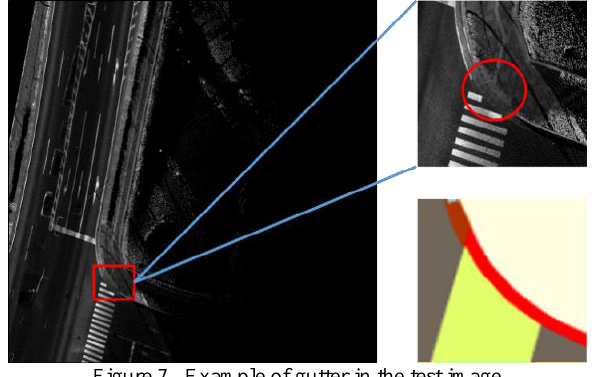
Figure 7. Example of gutter in the test image